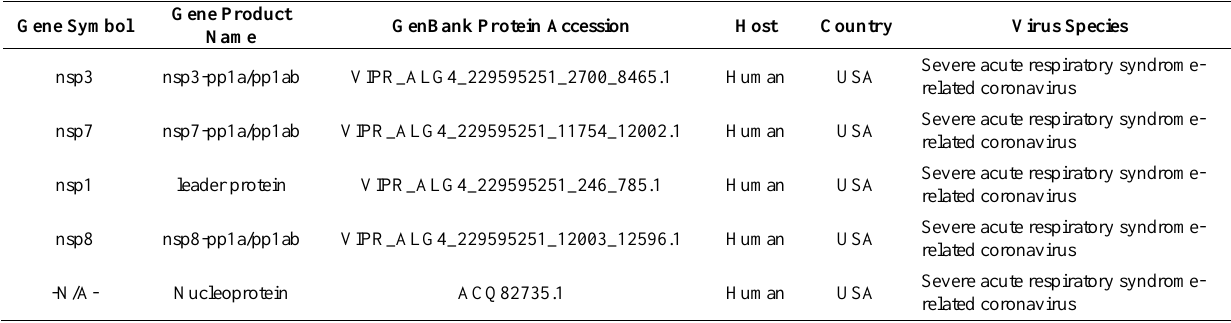
Table 1. Apart from the properties mentioned in the above table, other parameters obtained from the ViPR databases included the Protein Length, Maturation Status, Collection Data, Entire Protein Sequence Availability, Strain Name